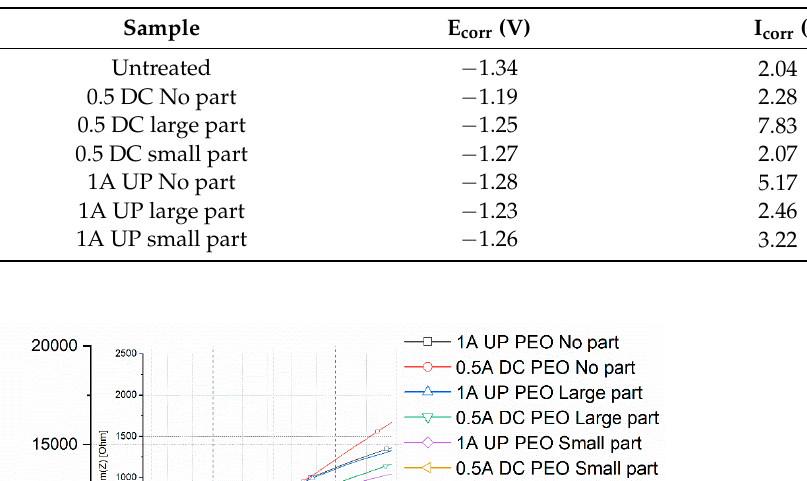
Figure 8. Results of potentiodynamic polarization tests (PDP) performed on the samples produced without particles and with “large” particles ( A ) and of the samples produced with “small” and “large” particles ( B ). Test electrolyte: 0.1 M Na 2 SO 4 and 0.05 M NaCl. Table 1. Corrosion current densities and corrosion potentials graphically extrapolated from the potentiodynamic polarization plots.